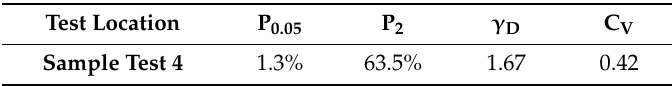
Table 2. Debris flow parameters at different points of Xiongmao Gully.